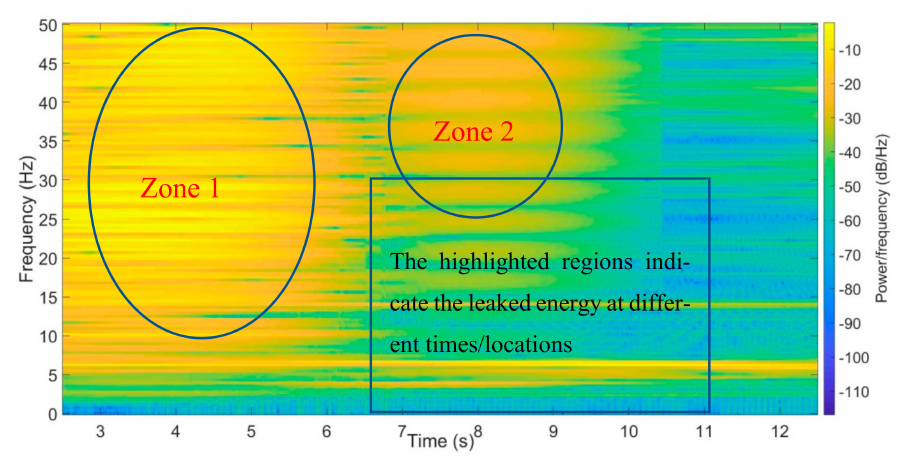
Figure 27. STFT results of vehicle’s right rear axle acceleration difference between the 40% damage case and the healthy bridge.